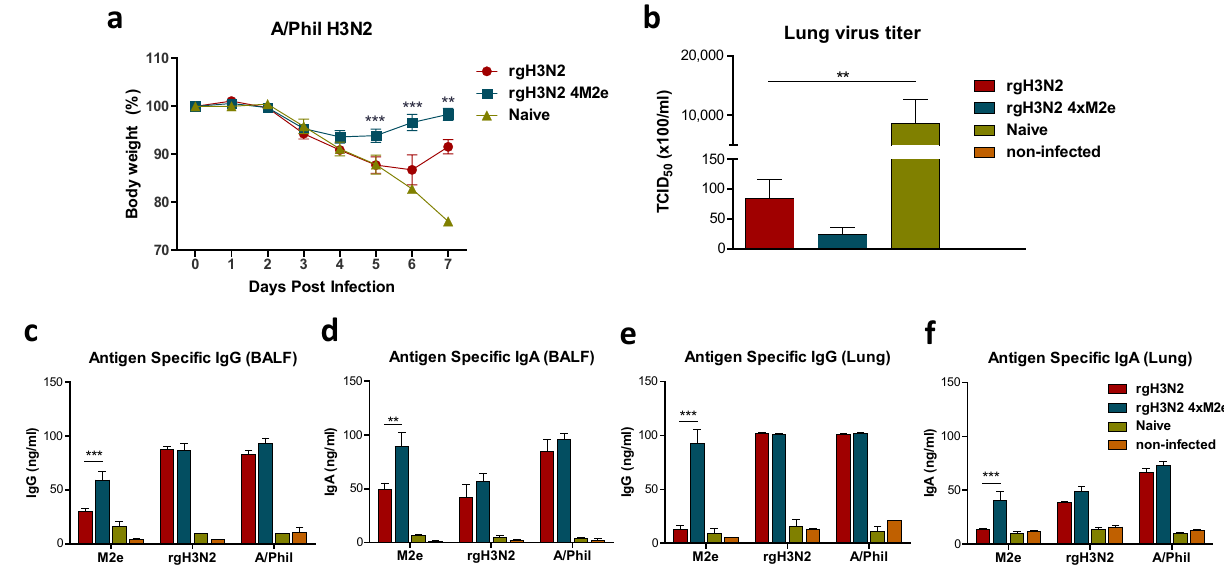
Figure 4. Prime dose rgH3N2 4xM2e provides enhanced protection against heterologous H3N2 A/Phil virus and M2e specific IgG and IgA antibodies in mucosal sites. The mice primed with rgH3N2 or rgH3N2 4xM2e were challenged with heterologous A/Phil H3N2 virus (50 LD 50 ). A relatively high challenge dose was used because of the same subtype virus. ( a ) Body weight changes after A/Phil challenge. Two independent repeat of mouse challenge experiments confirms the reproducibility of data. ( b ) Lung viral titers (TCID 50 × 100/ml) at 5-day post challenge with A/Phil. ( c – f ) IgG and IgA antibody responses specific for M2e or viral (rgH3N2, A/Phil) antigens in BALF and lung extracts at 5 days after challenge. ELISA viral antigens are rgH3N2 and A/ Phil. Error bars indicate mean value ± SEM. The statistical significances between rgH3N2 group versus rgH3N2 4xM2e group were determined using two-way ANOVA ( a , c – e ) or one-way ANOVA ( b ) and indicated in *, P < 0.05; **, P < 0.01; ***, P <